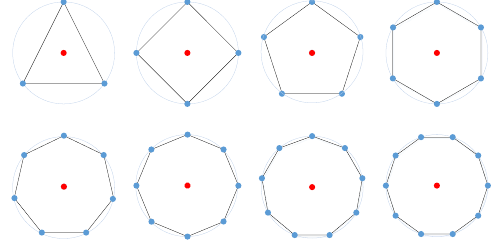
Figure 2. The Number of valid BLE signals Received